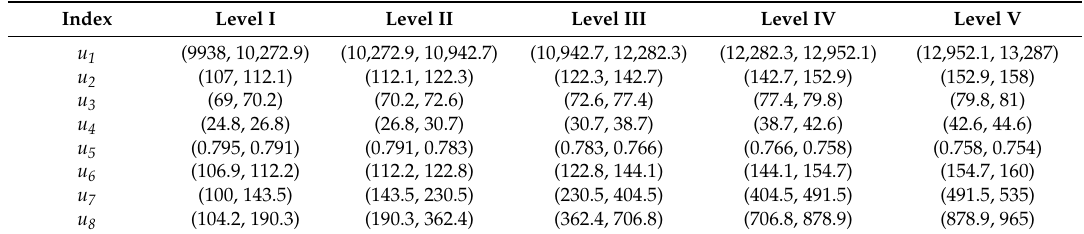
Table 11. Index criteria determination for risk assessment of mountain torrent hazards in Guizhou